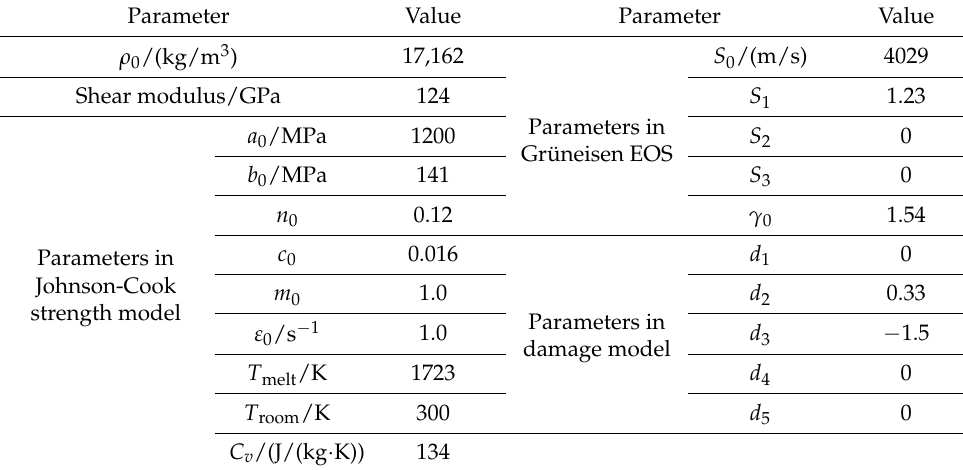
Table 1. Material parameters for projectile material.